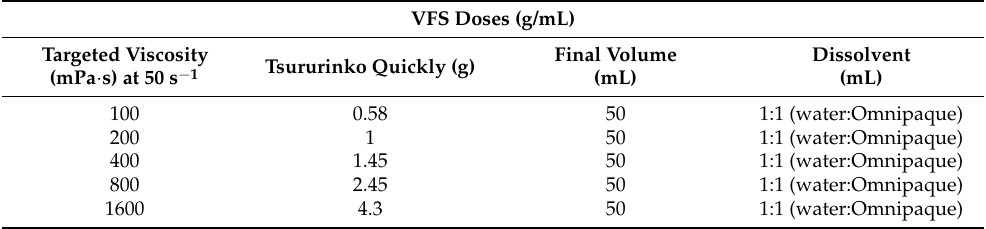
Table 6. Doses used to mix the videofluoroscopy doses.